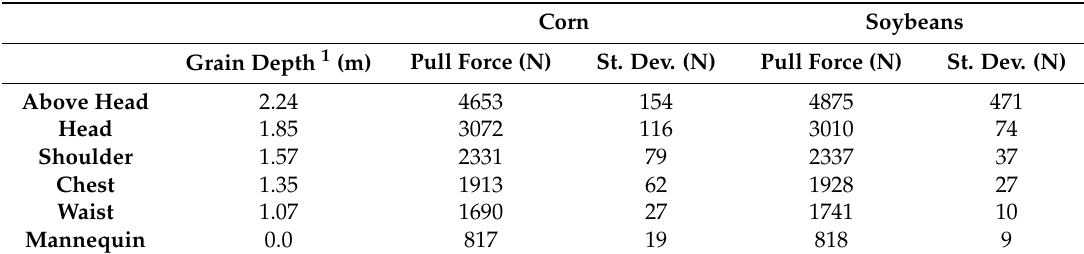
Table 1. Peak extrication force (in newtons w/standard deviations) required to free the mannequin entrapped vertically in corn and in soybeans at specified depth levels.